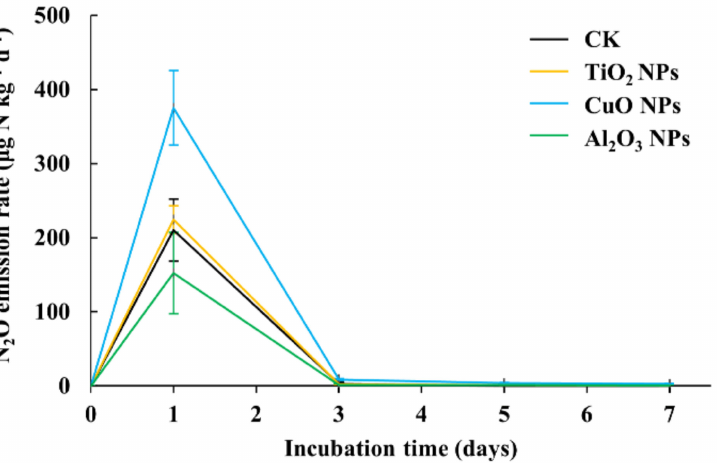
Figure 1. N 2 O emissions from tested soil under different nanoparticles. Error bars represent the standard error of the mean ( n =